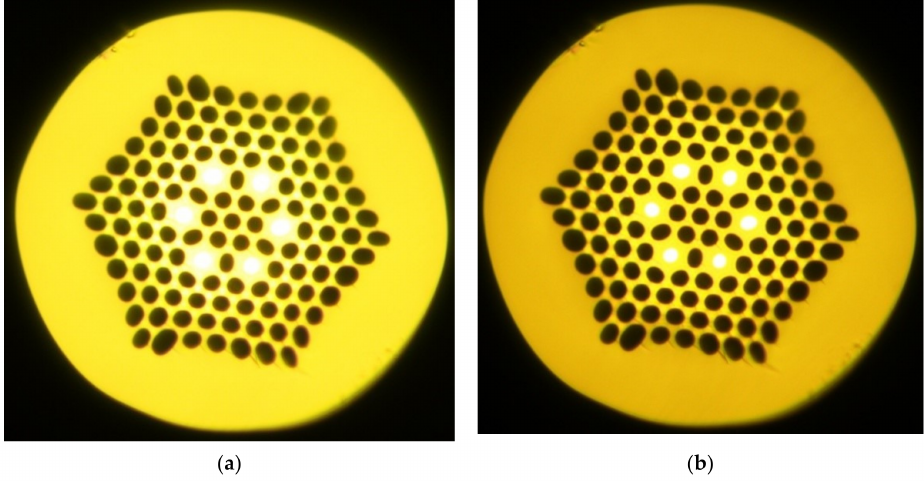
Figure 13. Six-core-MOFswithstep-indexcoresupportingelements: ( a )cross-sectionviewofthefabricated MOF with twisting 470 rpm; ( b ) cross-section view of the fabricated MOF with twisting 570